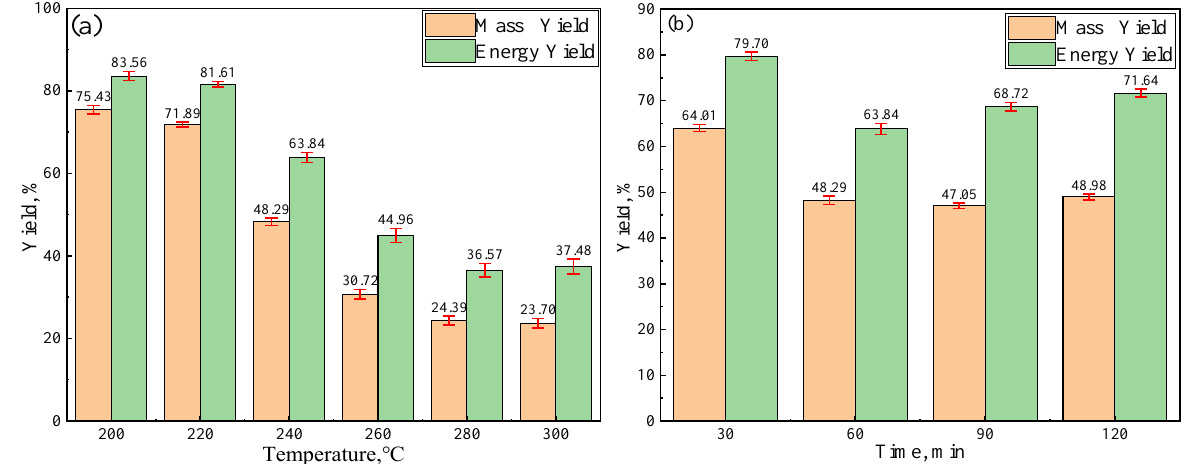
Figure 2. Effect of different HTC parameters on yield; ( a ) different temperatures; ( b ) different holding times.